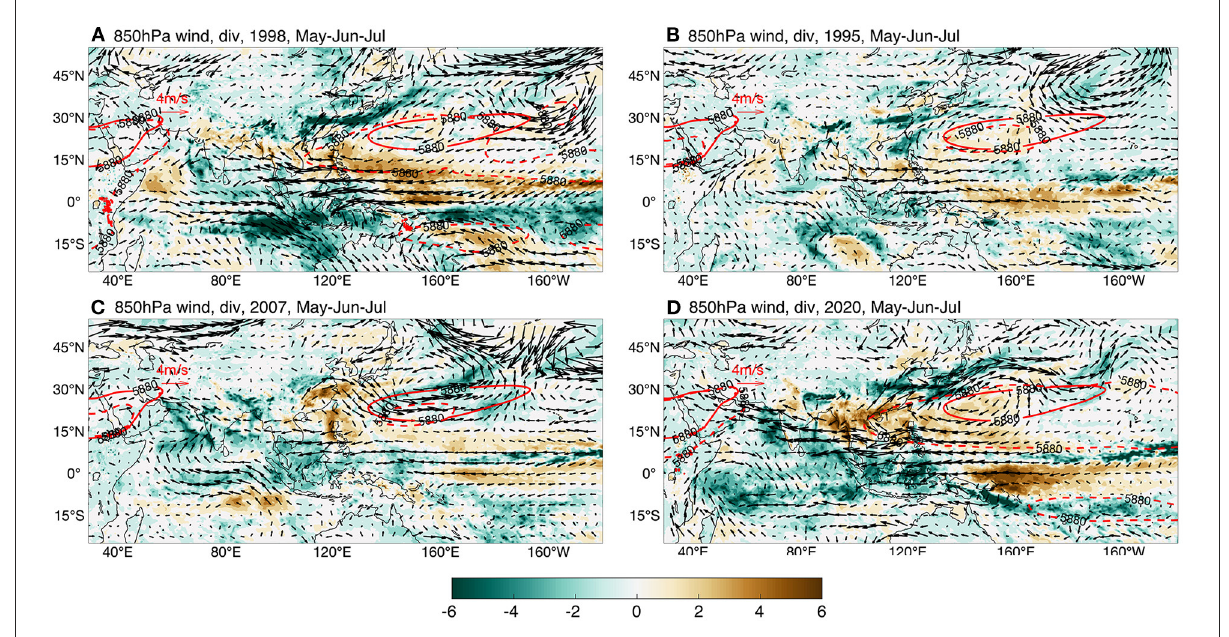
FIGURE11 May to July, 850hPa wind anomalies (vectors, m/s), vertically integrated moisture divergence anomalies (shading, kg m − 2 , negative values mean convergence) and the center of WPSH (the 5880 gpm, mean and anomalies, red contour lines) of 1998 (A) , 1995 (B) , 2007 (C) and 2020 (D) . The data were from ERA5. The anomalies are relative to 1979-2021.